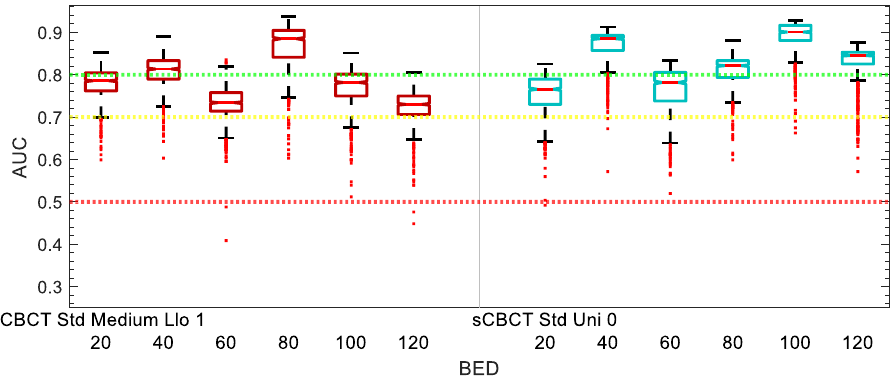
Figure 8. Sub-Acute GU Toxicity AUC of delta-radiomic models vs BED bins. The AUC collected over 1000 iterations of the leave-one analysis.